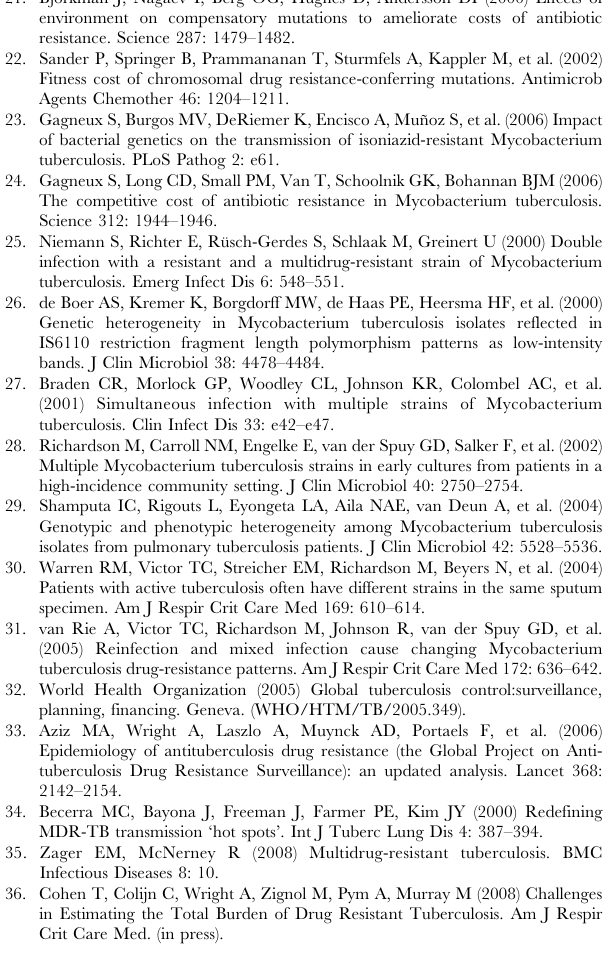
Figure S1 Probability trees demonstrate the order in which the probabilities of events are considered from each of the health/ disease states. Parameter explanations and values are provided in the Supplementary Table. The grey box in the upper right-hand corner shows the natural history model structure; the events possible from each of the disease states are linked to this overall model by the letters A through F.